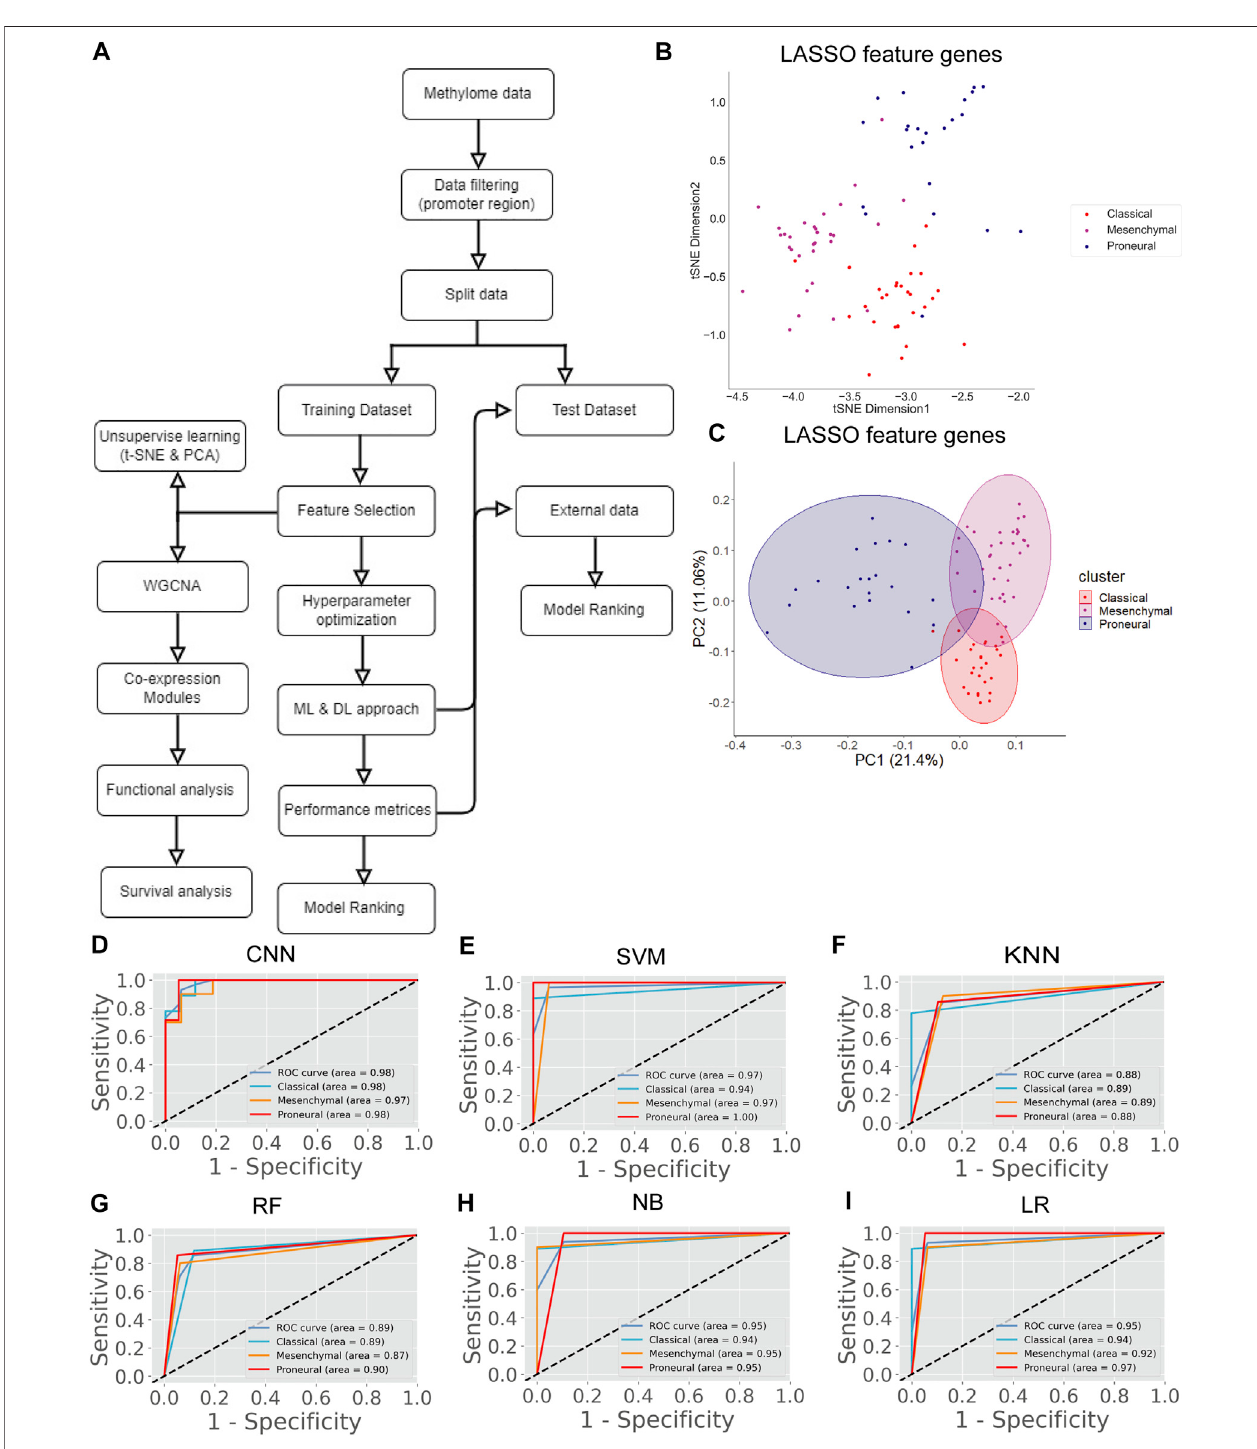
FIGURE2| GBMsubtypeclassi fi cationusingmethylomedata. (A) The fl owchartshowsDLandMLpipelinesusinggenome-wideDNAmethylationdatatoclassify the subtypes. (B, C) t-SNE and PCA plots to visualize the subtype-speci fi c clustering of the patients from features gene. (D – I) ROC of various prediction models. ROC plots were generated using the test data